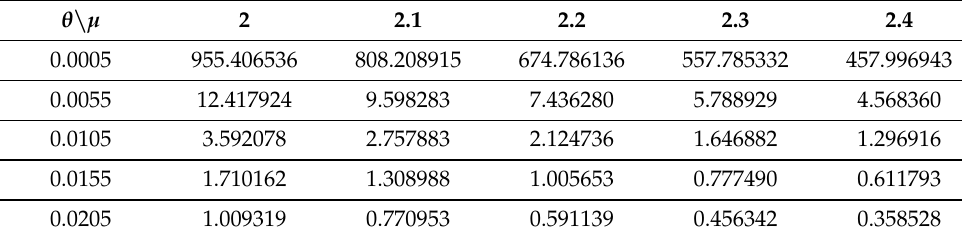
Table 4. Effect of θ vs. µ on the waiting time of a customer in the orbit ( Λ 4 ) .